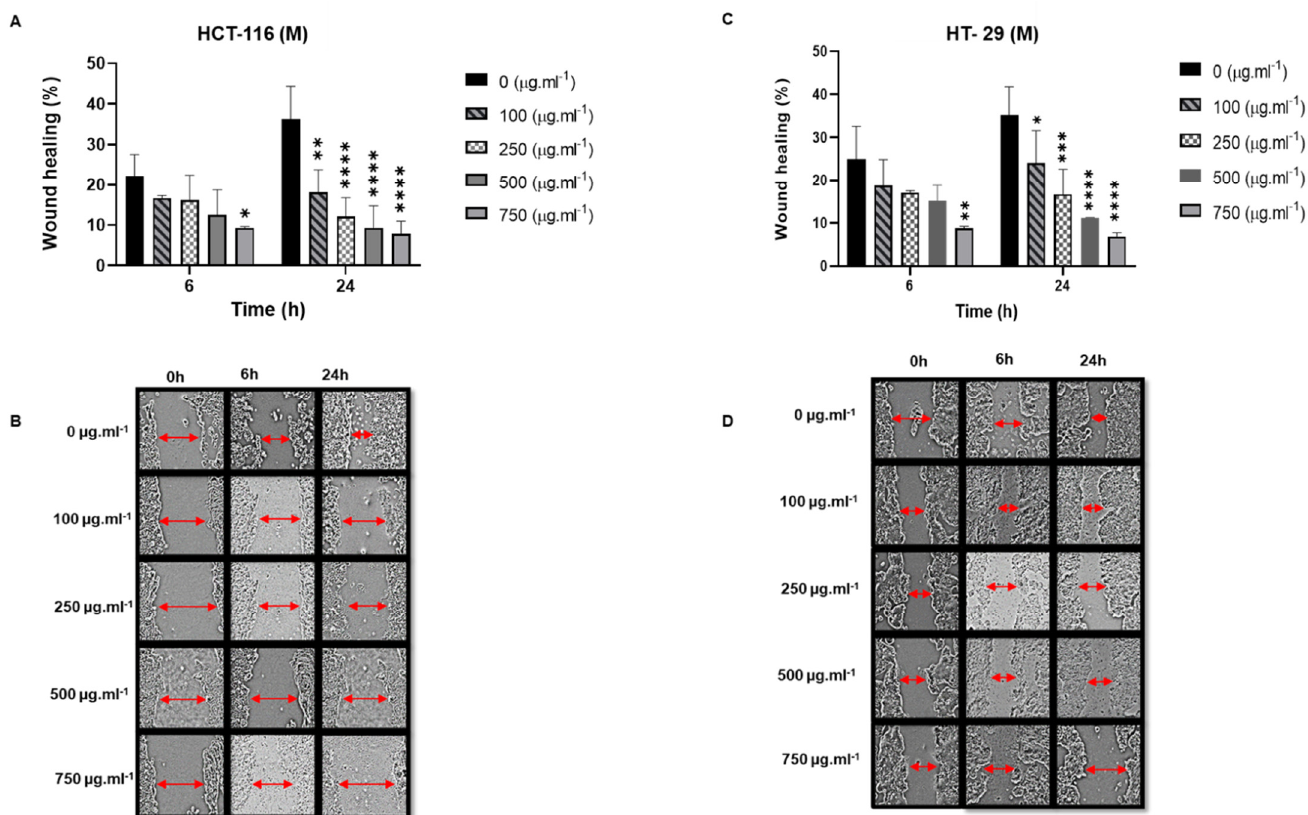
Figure 8. Wound-healing assay showing that M Soxhlet (100–250–500–750 µg.mL −1 ) inhibits the migration of HCT-116 and HT-29 cells after treatment for 24 h. ( A, B ) M Soxhlet treatment of HCT-116 cells. A. Percentage of wound-healing at 6 h and 24 h. B. Images of scratched HCT-116 cells taken at 0 h, 6 h, and 24 h. ( C, D ) M Soxhlet treatment of HT-29 cells. C. Percentage of wound-healing at 6 h and 24 h. D. Images of scratched HT-29 cells taken at 0 h, 6 h, and 24 h. Representative images were captured by a Leica microscope. Data are reported as mean ± SD, n = 3. * p < 0.05, ** p < 0.01, *** p < 0.001, and **** p < 0.0001 vs. control group. M: methanol.